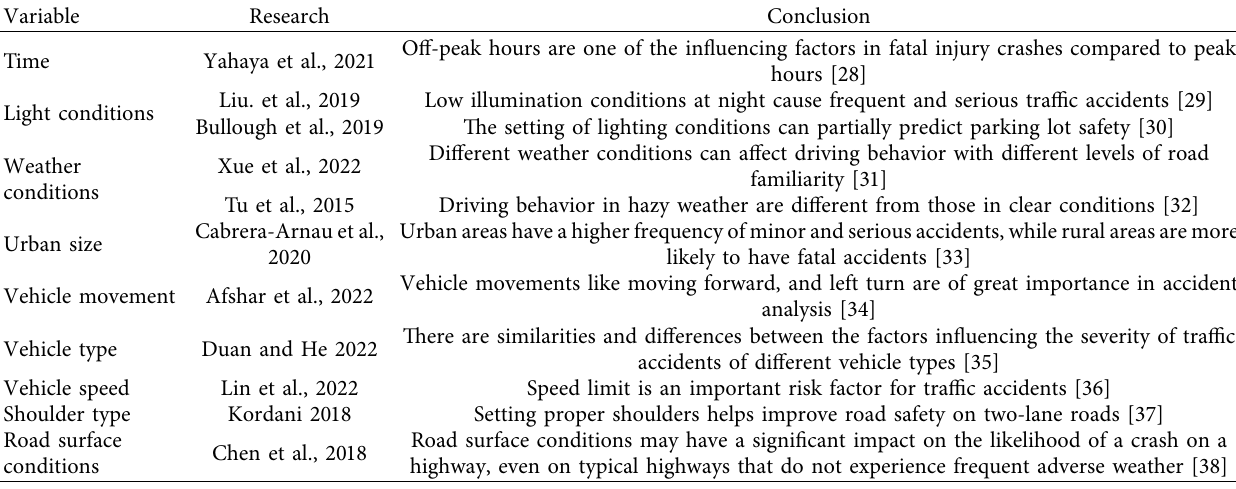
Table 1: Summary of potential factors afecting parking